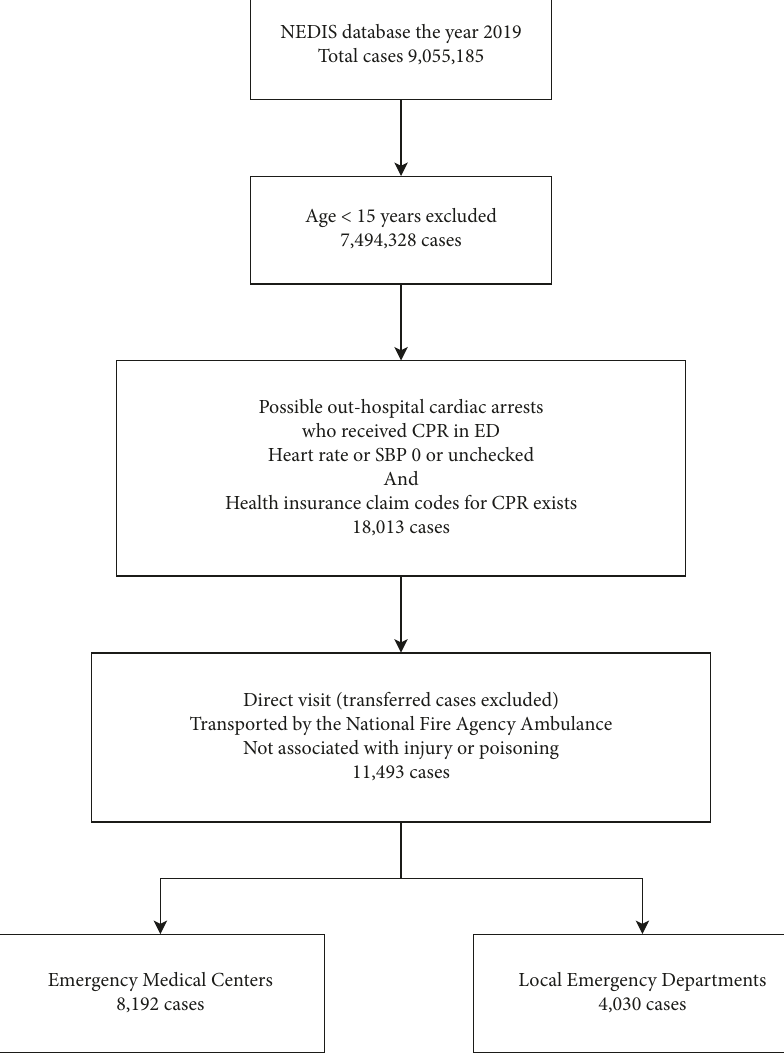
Figure 1: Flow diagram illustrating included and excluded cases of out-hospital cardiac arrest. NEDIS: national emergency department information system; CPR: cardiopulmonary resuscitation; ED: emergency department; SBP: systolic blood pressure; EMC: emergency medical